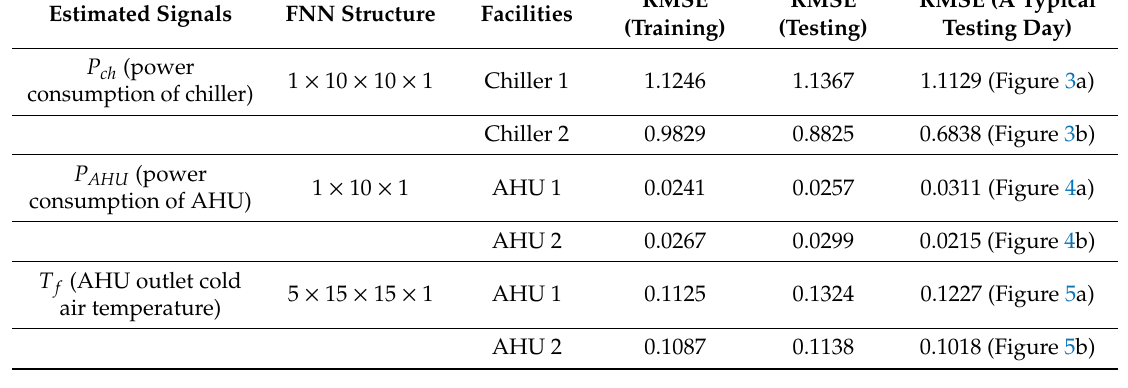
Table 1. Comparison of RMSE of estimated signals for training and testing results.